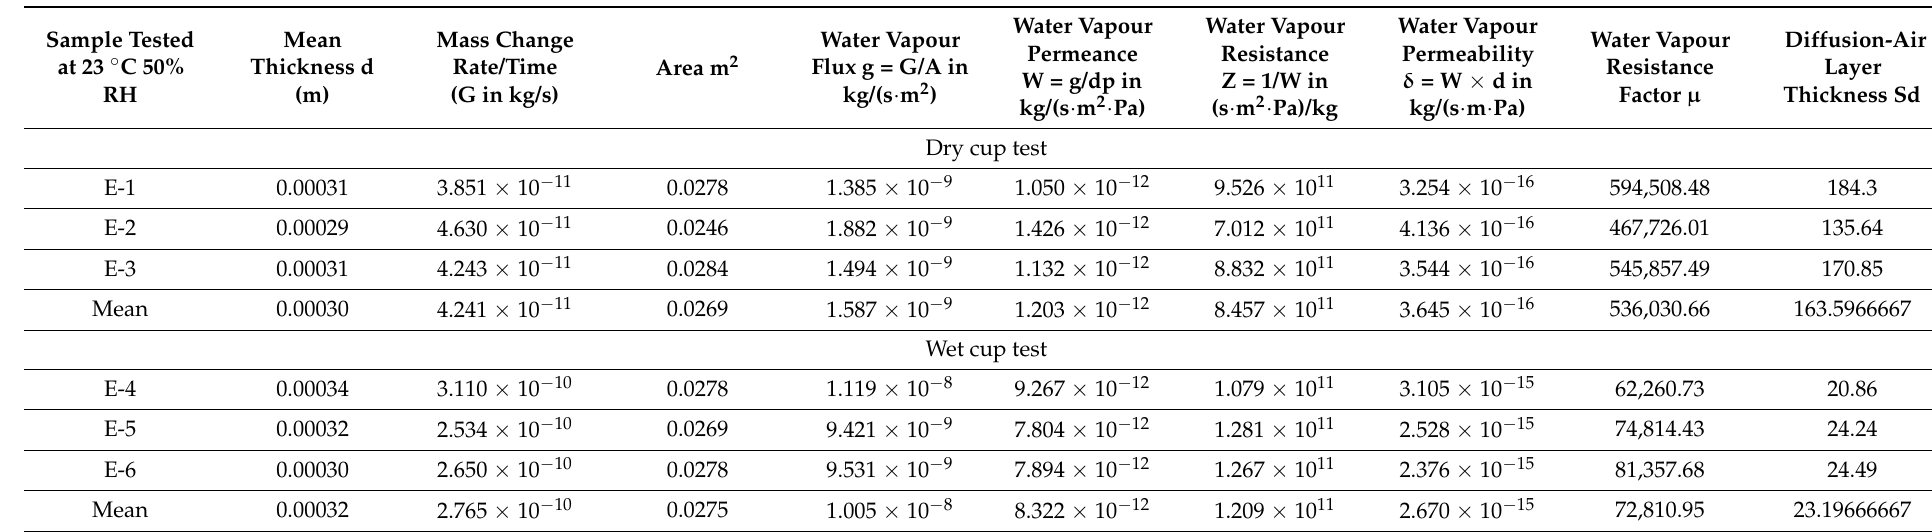
Table A11. Water vapour resistivity properties for sample E at 23 ◦ C 50%